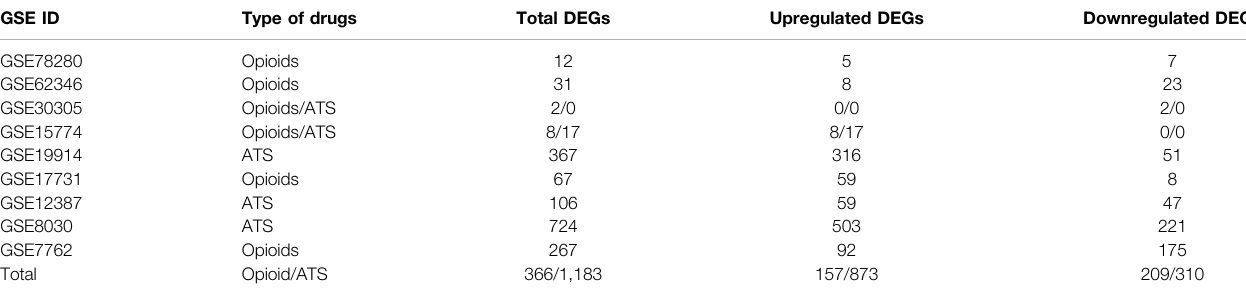
TABLE 2 | The number of differentially expressed genes (DEGs) in each database by GEO2R.